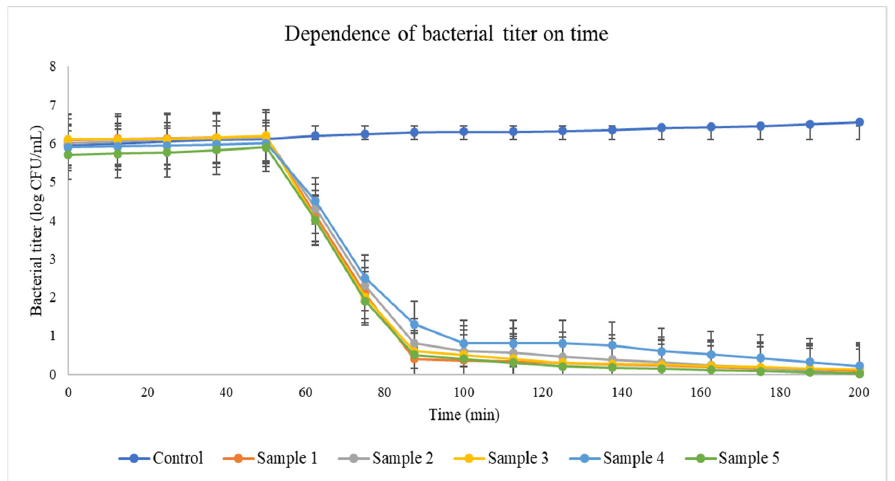
Figure 2 . Bacteriolytic effect of phage cocktail on pectobacterial strains in vitro . The mixture